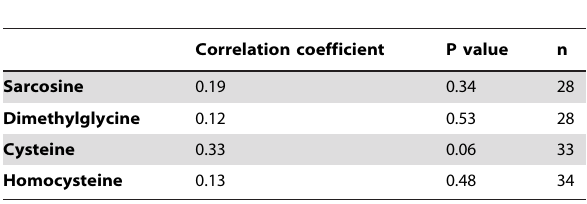
Table 3. Correlations between serum and urine